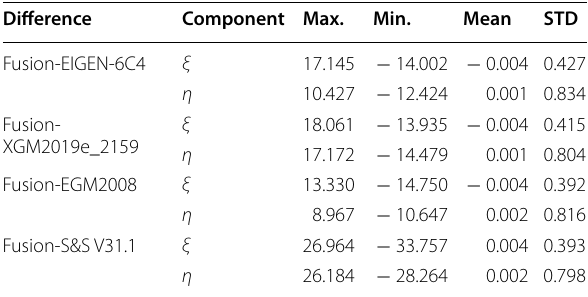
Table 5 Accuracy evaluation results of the fused deflections of the vertical (unit: arcsec) Difference Component